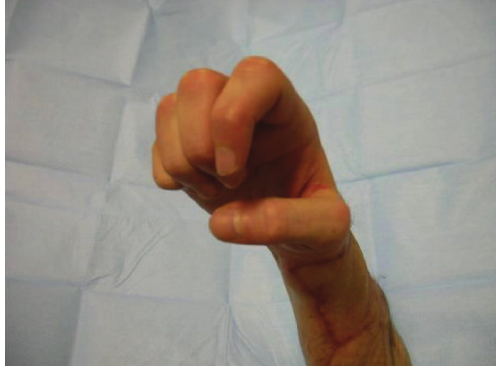
Figure 6: X-ray showing a further displacement of the fracture fragment of the radius, with ulnar deviation of the wrist.